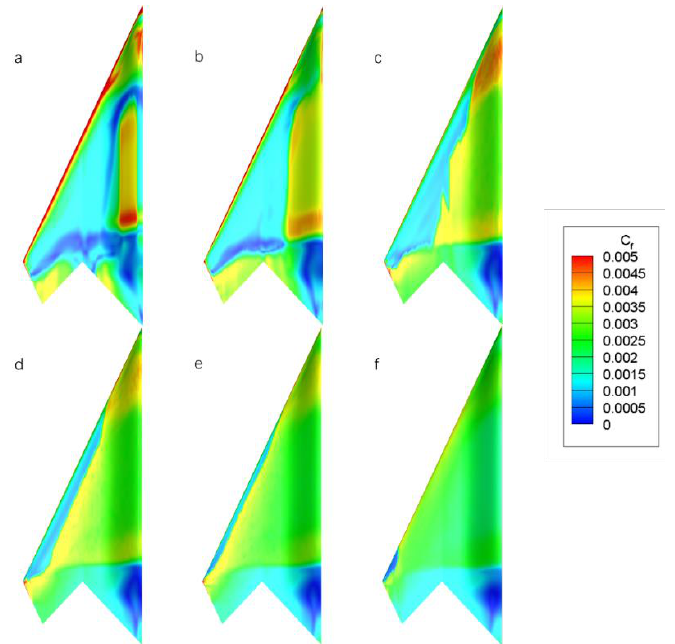
Figure 7. Friction coefficient distributions on the upper surface of the flying wing model with different Reynolds numbers ( M = 0.9, α = 2°, T u = 0.1%): ( a ) Re = 1 × 10 6 ; ( b ) Re = 2 × 10 6 ; ( c ) Re = 5 × 10 6 ; ( d ) Re = 10 × 10 6 ; ( e ) Re = 20 × 10 6 ; ( f ) Re = 80 × 10 6 .